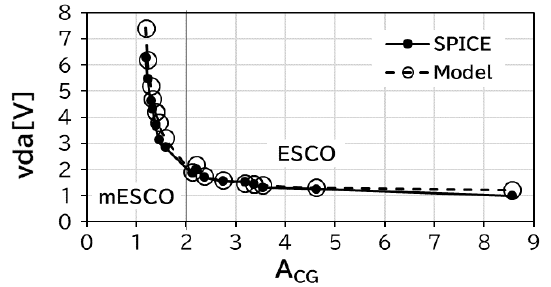
Figure 14. vda of ESCO and mESCO as a function of A CG .